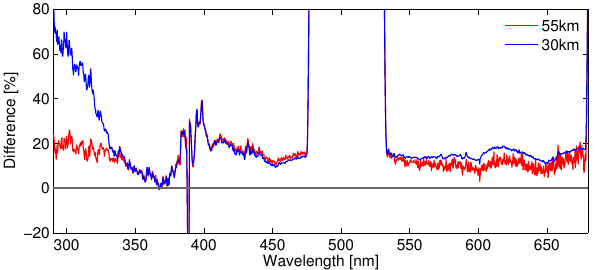
Fig. 6. Median relative difference of the 14 OSIRIS and stray light corrected GOMOS absolute radiances at 30km (blue) and 55km (red).